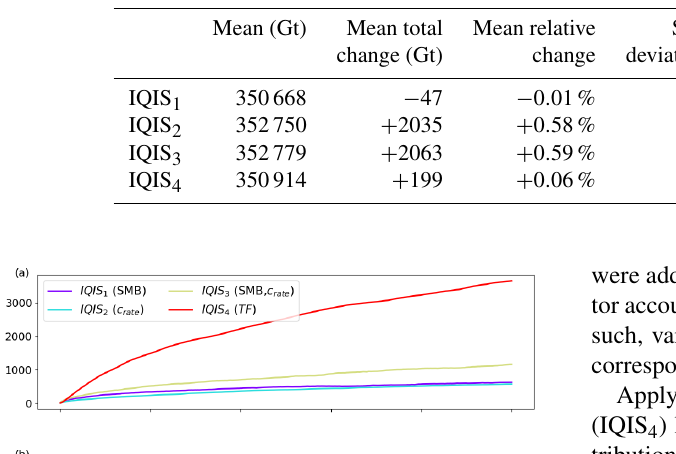
Table 5. Statistics of the final ice mass distributions for the four IQIS ensembles. The relative change is calculated with respect to the initial ice mass (350715Gt).